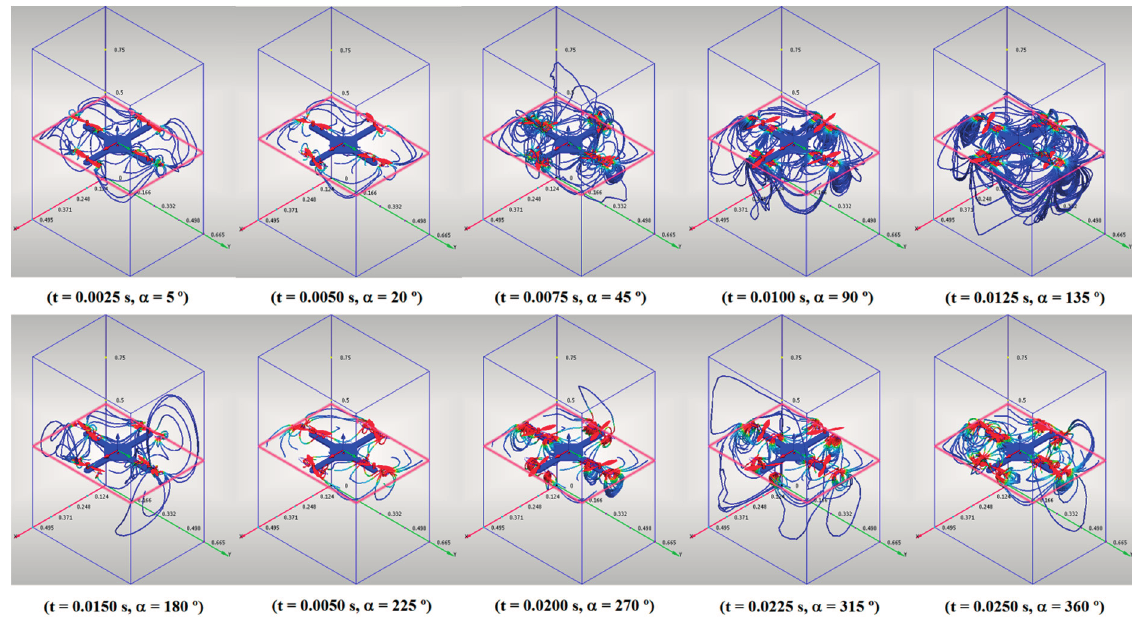
Figure 4. Airflows under the quadrotor.